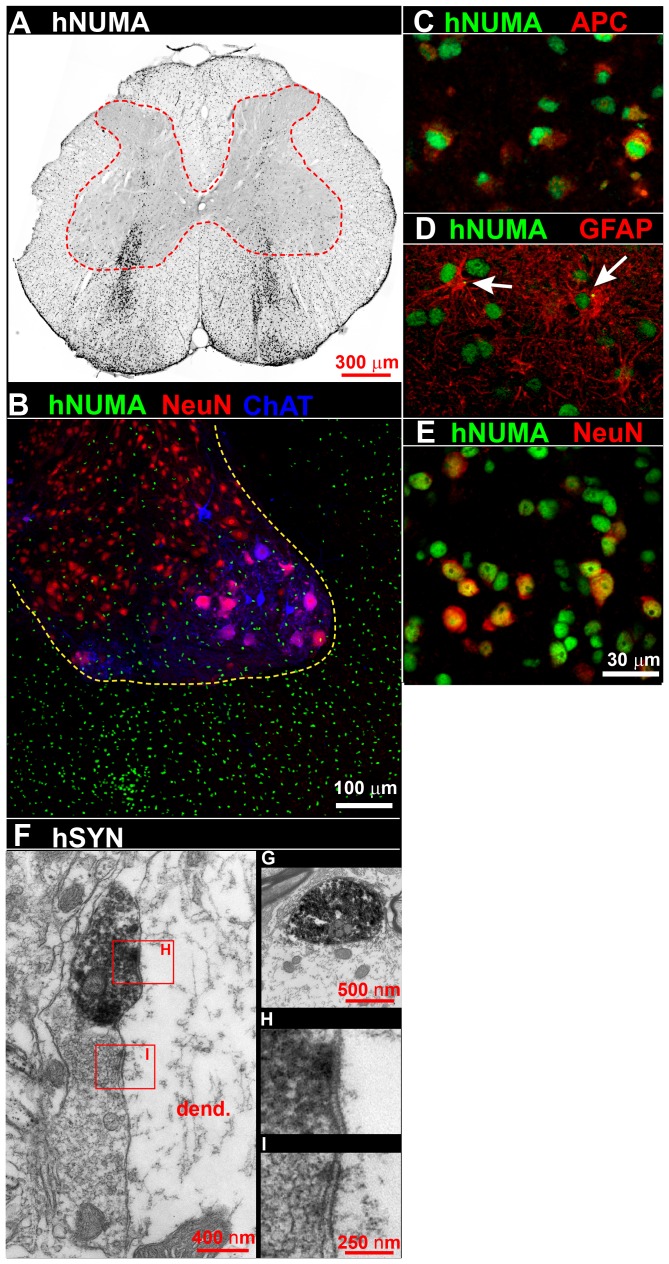
Effective re-population of lumbar gray and white matter by human spinal neural stem cells nine months after lumbar transplantation in immunodeficient rats.When human spinal neural stem cells (same cell line as were used in the grafting experiments in
Fig. 1
,
2
 and Fig. S2, S3) were transplanted into the lumbar spinal cord of immunodeficient rats, histological sections taken after nine months of survival revealed a near homogenous distribution of human cells (hNUMA; A, B) in both gray and white matter. In white matter hNUMA-IR cells were primarily oligodendrocytes (adenomatous polyposis coli; APC; C) or astrocytes (GFAP; D) while in gray matter a neuronal phenotype (NeuN; E) was identified. Electron microscopy revealed axon terminals, enriched with human synaptophysin immunoreaction product (F, G), forming synapses with host neurons or dendrites (F, H, I). Scale bar: 300 µm (A), 100 µm (B), 30 µm (C–E), 400 nm (F), 500 nm (G), 250 nm (H, I).